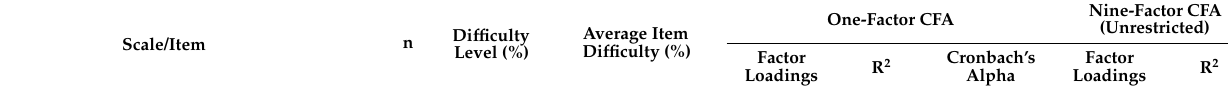
Scale 2. Having sufficient information to manage my health (Table 1). Table 1. Difficulty level and psychometric properties of English HLQ among students in Nepal (Part 1 Scales 1 – 5